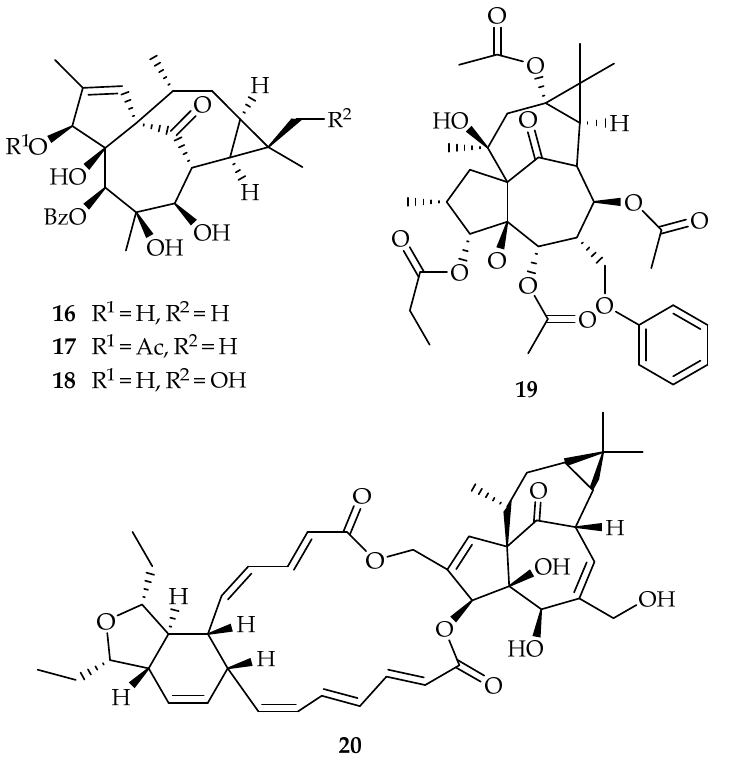
Figure 8. Structures of kansuingenol A-C 16 – 18 [16], compound 19 [17], and euphorkanlide A 20